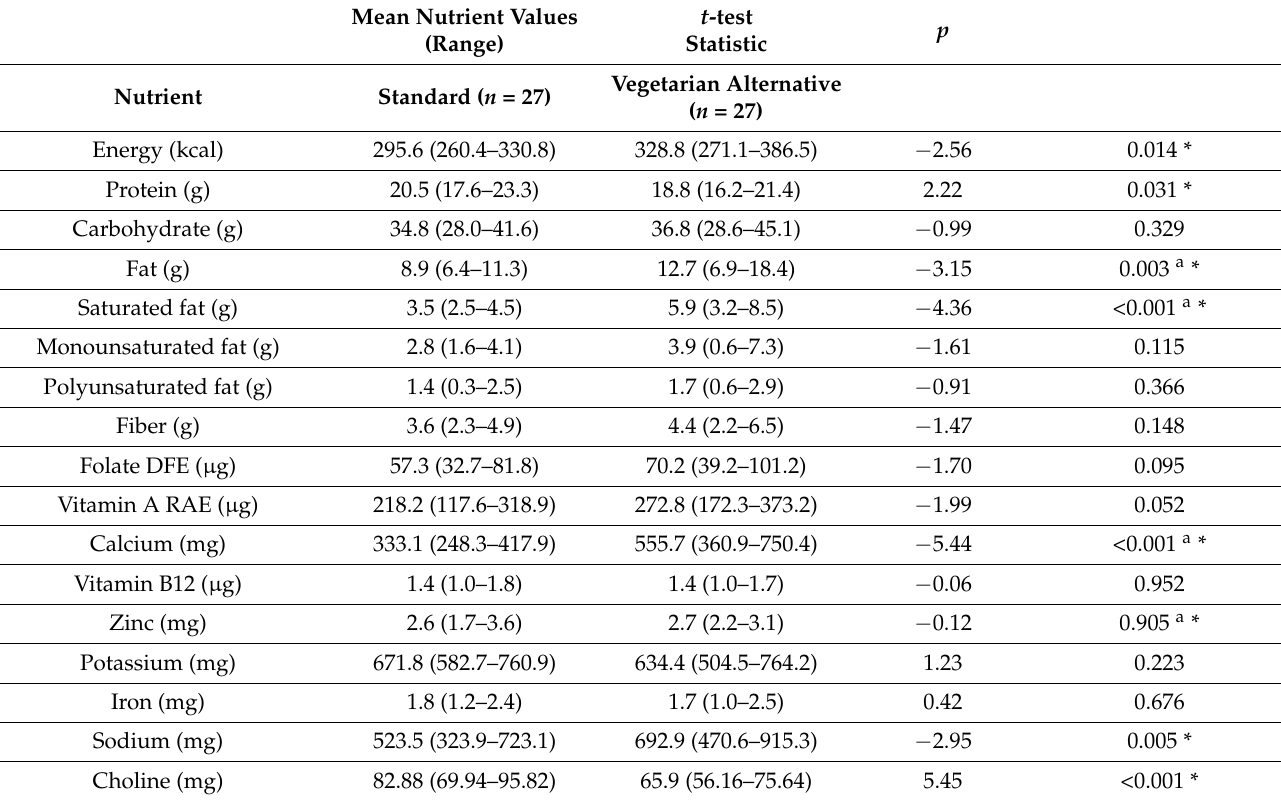
Table 2. A t -test comparison of the standard and vegetarian alternative lunch menu nutrient values.